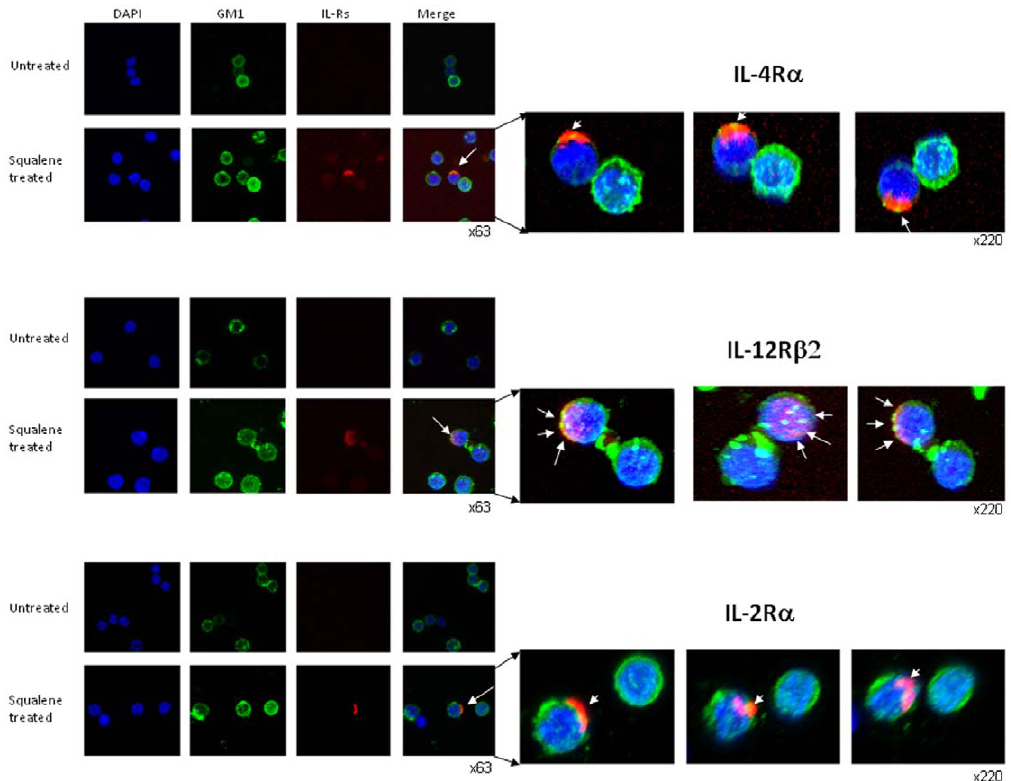
Figure 4. Co-localization of cytokine receptors with lipid rafts of resting CD4 T-cells before and after squalene treatment. Resting CD4 T-cells from individual F1 mice (n=5/group) before and 7 days after squalene treatment (180 m g/mouse) were analyzed for interleukin receptor expression and distribution at the single-cell level by CLSM. Cells were stained with IL-4R a -, IL-12R b 2-, or IL-2R a -PE conjugates, and co-stained for GM1 ganglioside by CTB- FITC conjugate and for nuclei with DAPI. First column indicates single-channel color for DAPI staining (blue), second column indicates GM1 staining (green), third column indicates interleukin receptor (IL-Rs) staining (red), and last column indicates merged channels at X63 magnification. Top-two rows , indicate cells from untreated ( upper row ) and squalene treated mice ( lower row ) stained for IL-4R a . Middle-two rows , indicate cells from untreated ( upper row ) and squalene treated mice ( lower row ) stained for IL-12R b 2. Bottom-two rows , indicate cells from untreated ( upper row ) and squalene treated mice ( lower row ) stained for IL-2R a . Arrows indicate presence of IL-Receptor co-expression with the GM1 resident of lipid rafts. Enlargements of the merged channels are depicted to the right along with two different angles of the membrane for each IL-Receptor at X220 magnification. Shown are representative images in one of three experiments.